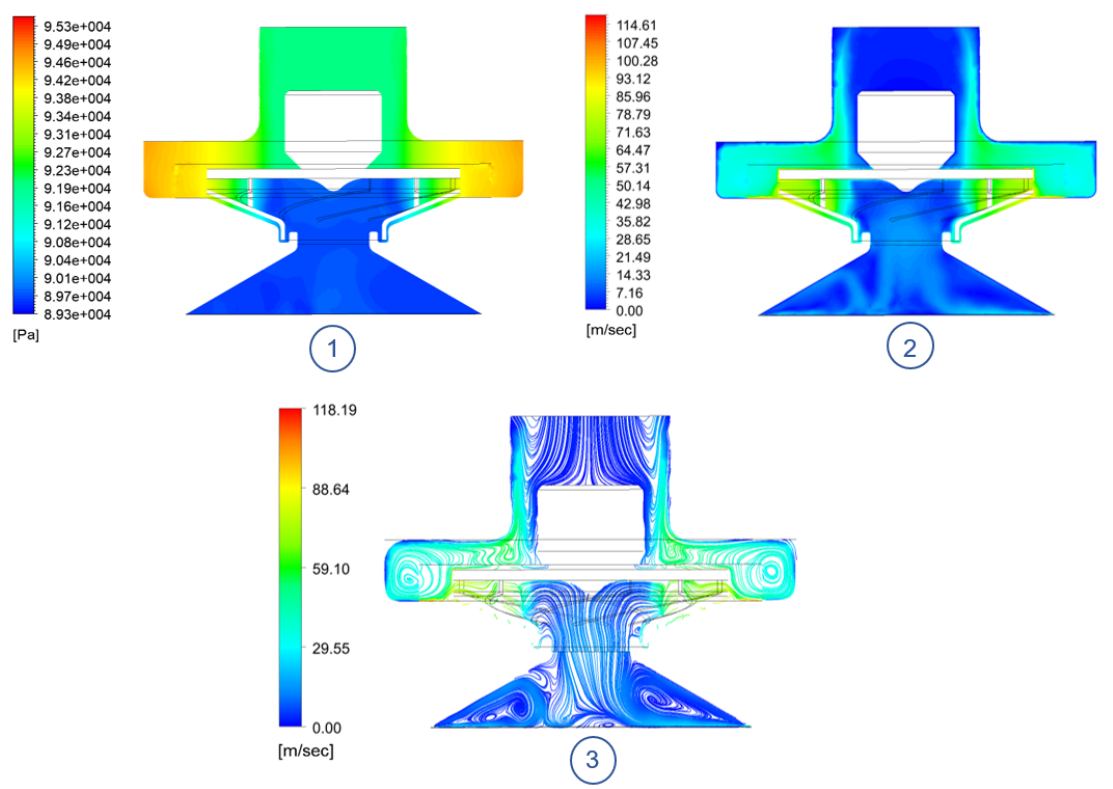
Figure 15. ORP model median plane @ 29,090 RPM: ( 1 ) Absolute pressure contour. ( 2 ) Velocity contour. ( 3 )